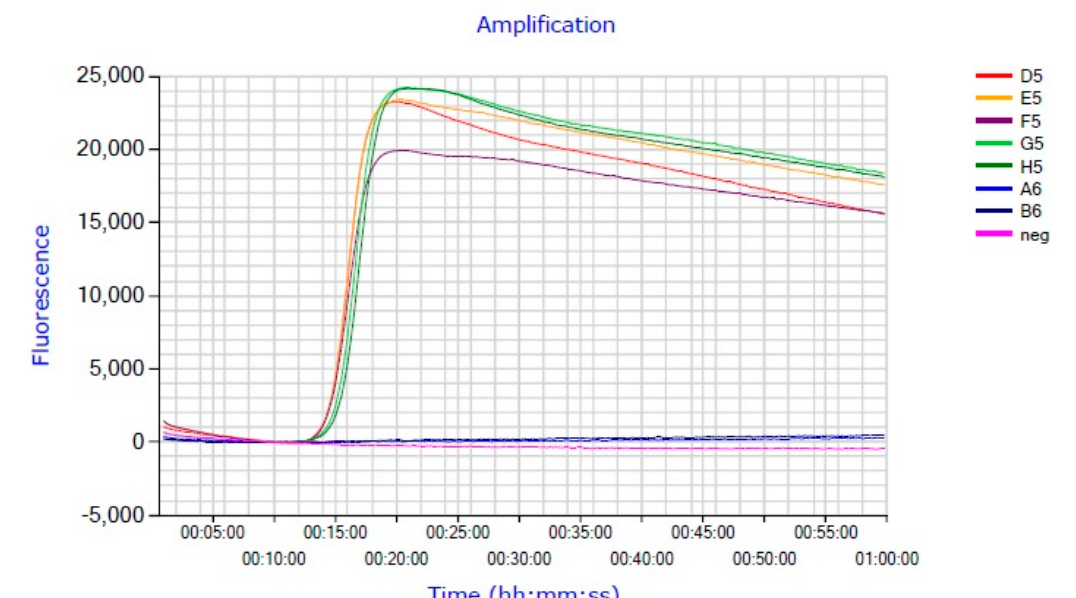
Figure 2. Output from LAMP assay to assess specificity of D. septosporum lamp assay. D5 = D. septosporum (DSEP-FLNRO-7M-